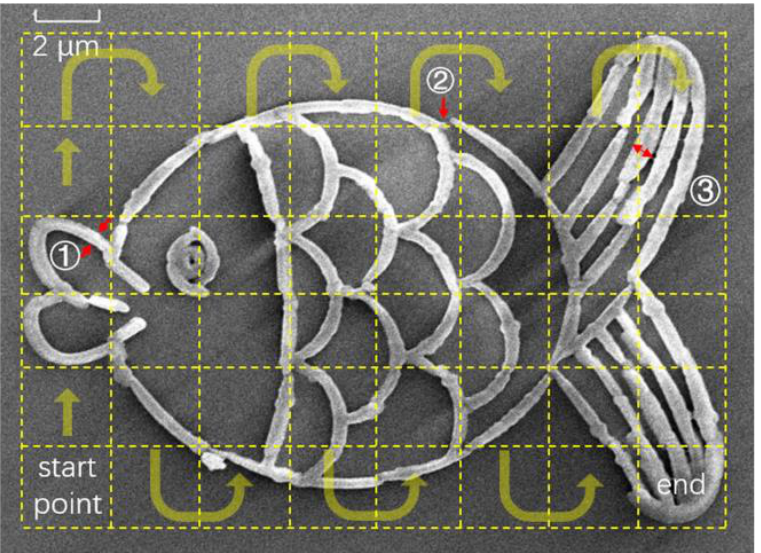
Figure 8. Fabrication of a large–area carp structure with three Bessel–Gaussian laser spots. The size of the carp structure was 18.10 μm × 24.56 μm. Here, 𝑑 = 0.39 μm and ∆𝑑 = 0.07 μm. The laser power was 13.5 mW and the exposure time for a single phase map was 17 ms. The fabrication process follows the yellow arrow from the start point to the end. The red arrows and its corresponding serial numbers ① , ② , ③ indicate the problem observed in fabrication .